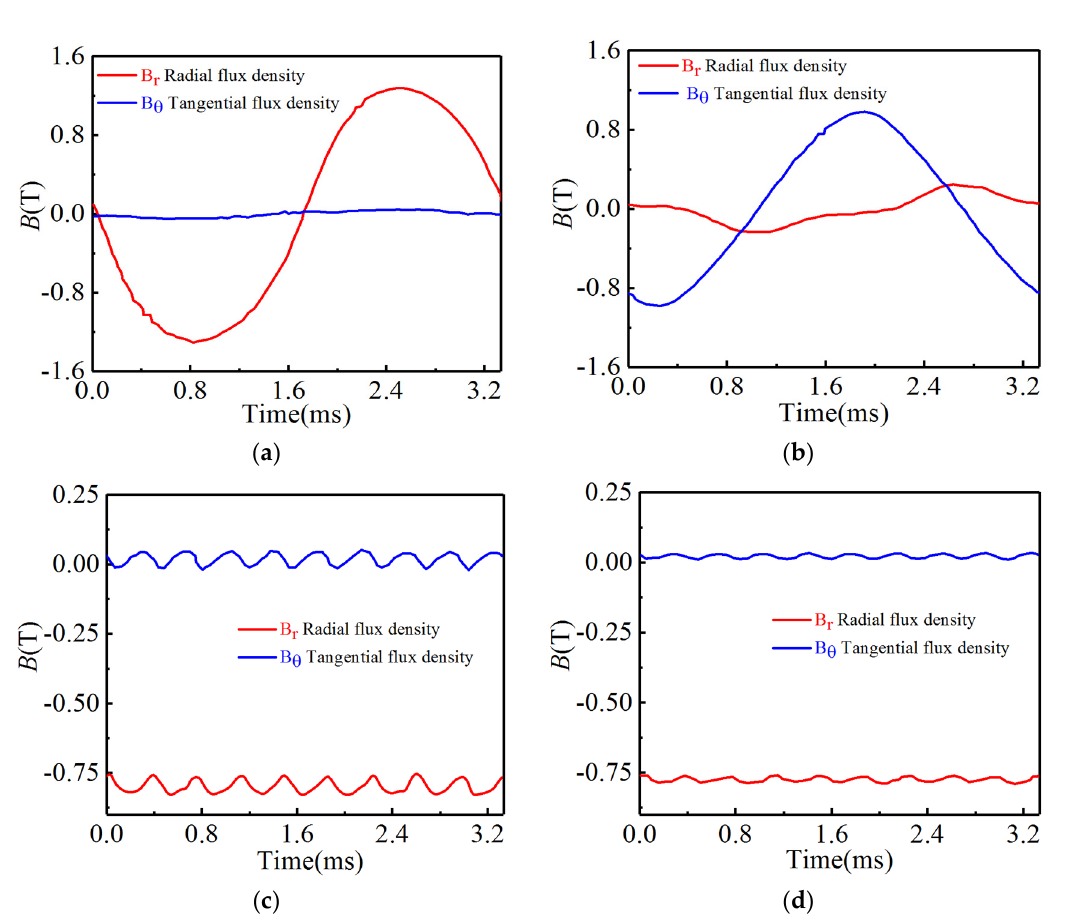
Figure 11. Magnetic flux density waveforms at points ( a – d ) on the motor.